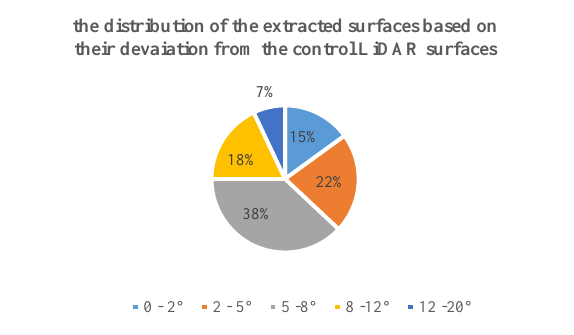
Figure 13. The distribution of the extracted surfaces from imagery-based point cloud based on their deviations from matched LiDAR-derived control surfaces The third experiment provides photo-realistic 3D models